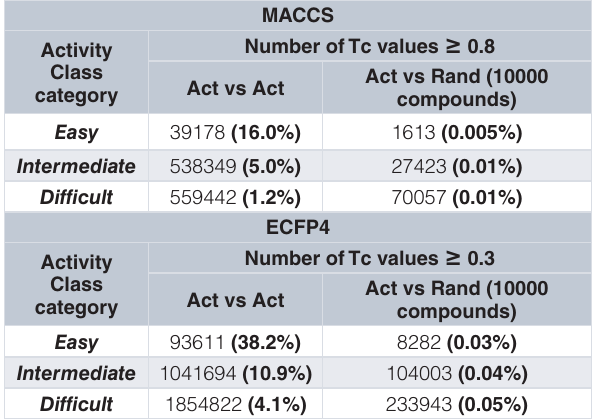
Table 1. Similarity values falling into activity-relevant